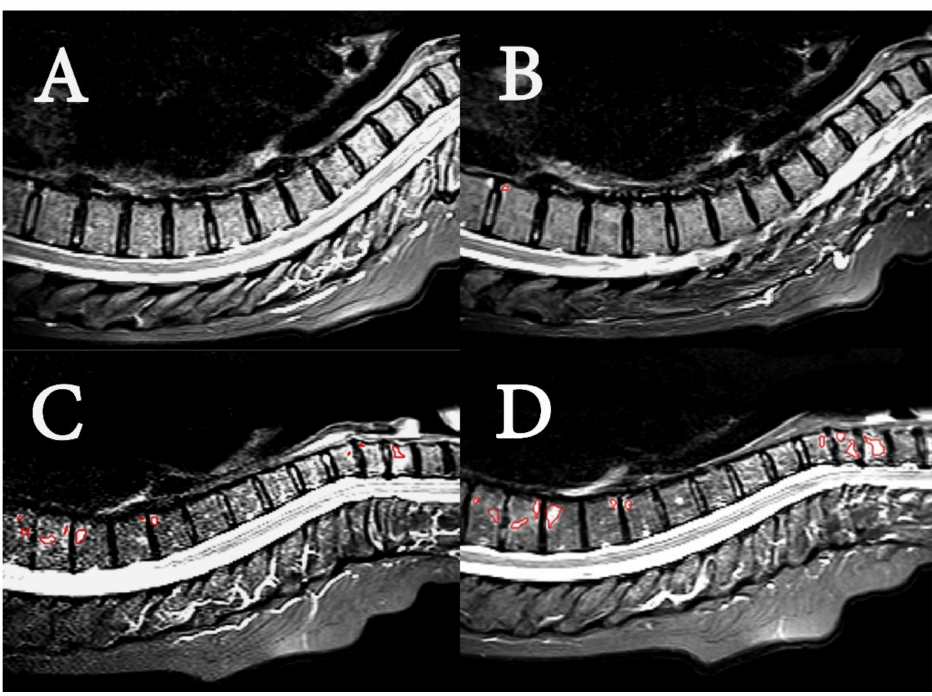
Figure 2. MR image examples. Sagittal short tau inversion recovery (STIR) MR images of upper spine in two patients. ( A ) (baseline) and ( B ) (11 weeks) are of a patient with low SPARCC scores (4 and 2, respectively). The images show the spine from the second cervical vertebrae (C2) to thoracic vertebrae 12 (TH12). Segmented region in red in B shows minor BME in corner of TH10. ( C ) (baseline) and ( D ) (11 weeks) are of patient with high SPARCC scores (39 and 50, respectively). The images show the spine from the second cervical vertebrae (C2) to thoracic vertebrae 11 (TH11), and segmented regions in red in ( C ) and ( D ) show BME in C5 to C7, and in TH5 to TH9. Table 2. Bone marrow edema by radiological evaluation of MR images. Results from radiological evaluation for bone marrow edema (BME) in short tau inversion recovery (STIR) and T1-weighted MR images of the participants in high intensity interval training (HIIT) and control groups at baseline and after 11 weeks. Number of participants with detectable changes after 11 weeks were not significantly different for the two groups (Fisher’s Exact Probability Test p -value: 0.50). HIIT Controls Baseline 11 Weeks Baseline 11 Weeks Number, n 17 20 BME detected, n (%) 9 (53) 9 (53) 5 (25) 5 (25) No change, n (%) Increased BME, n